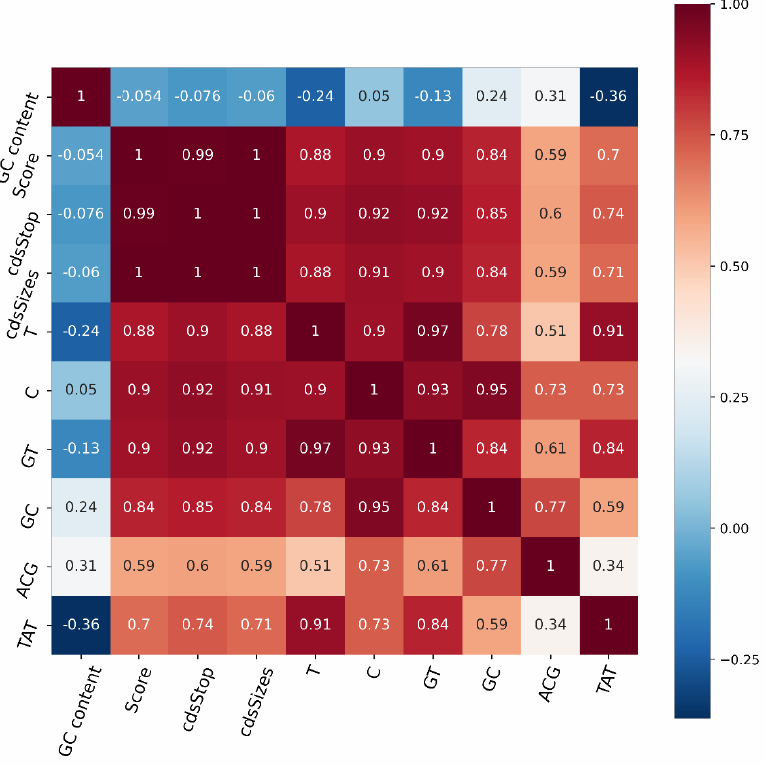
Figure 3 . Correlation analysis chart of 10 features selected for the classification task. Figure 3. Correlation analysis chart of 10 features selected for the classification Table 1. Comparing the performance of different feature selection methods.